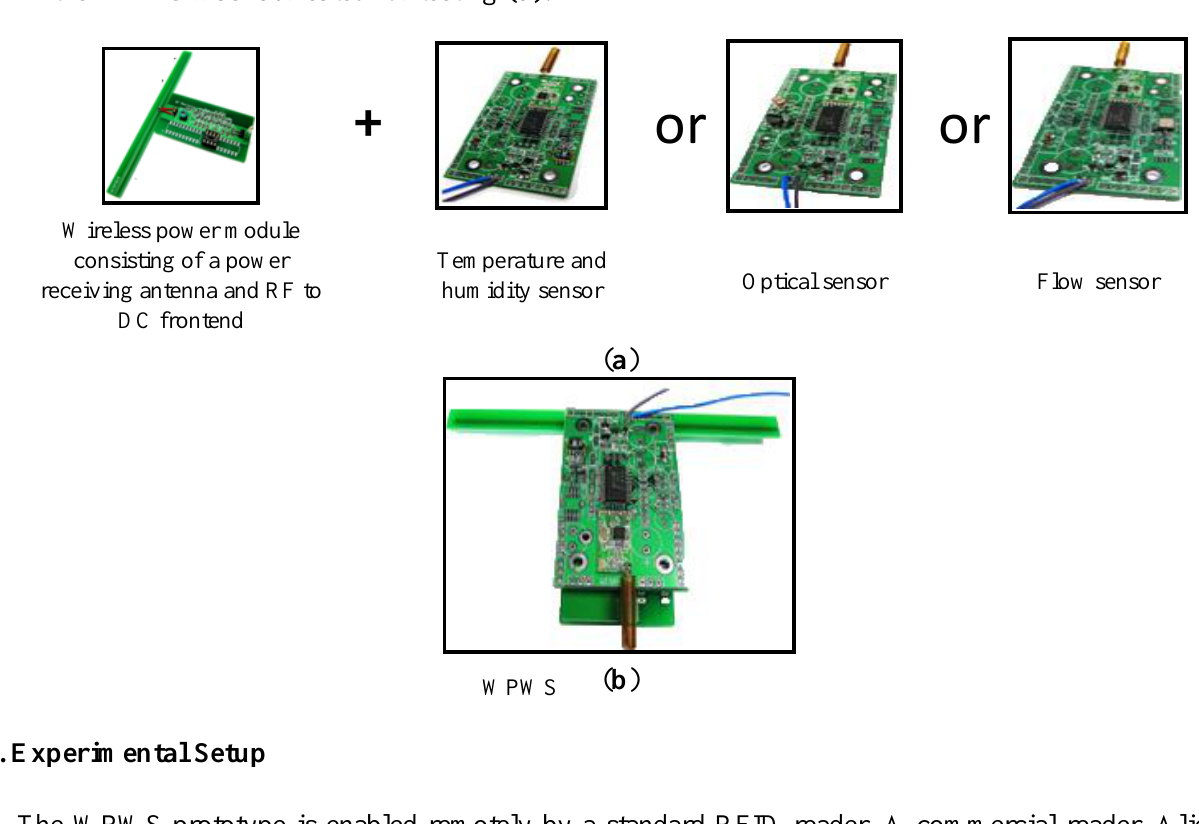
Figure 9. Combining wireless power module and each sensor module as shown in ( a ), the WPWS was fabricated for testing ( b